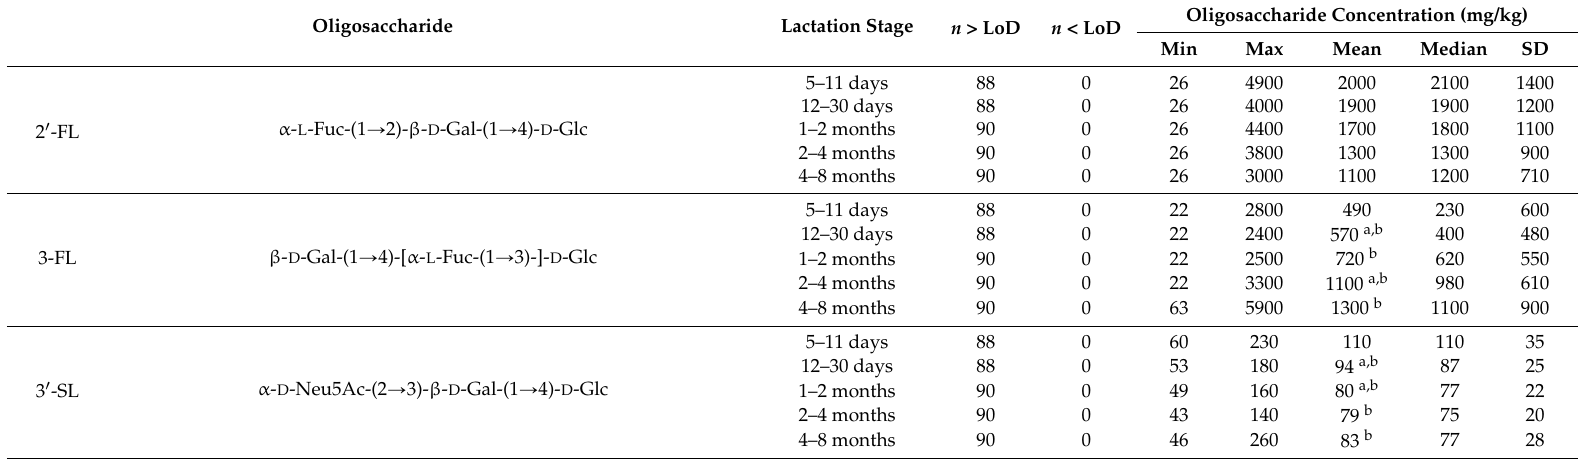
Table 3. Concentration of oligosaccharides in human milk, with samples having concentrations >LoD, but <LoQ assigned a value of half the